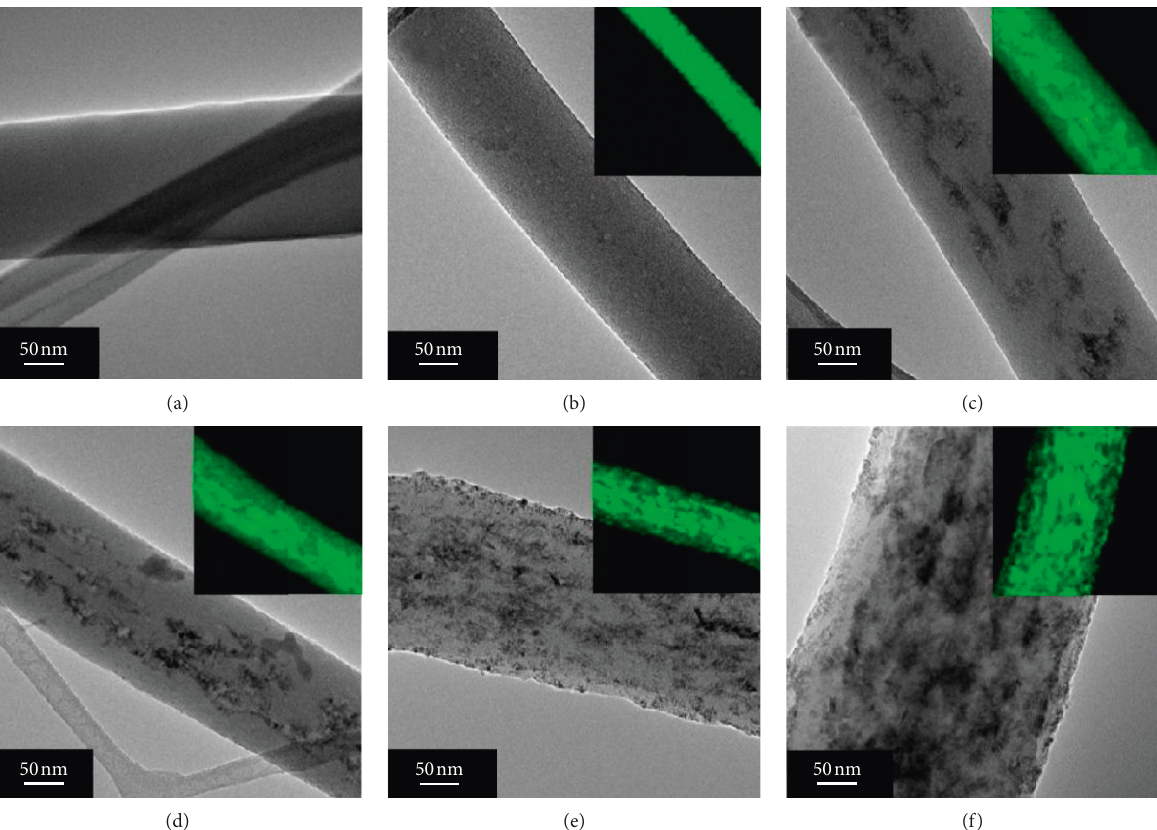
Figure 9: TEM images of CNFs containing ZnO nanoparticles of (a) 0, (b) 13.6, (c) 19.0, (d) 25.7, (e) 29.5, and (f) 34.2 wt.% (image taken from